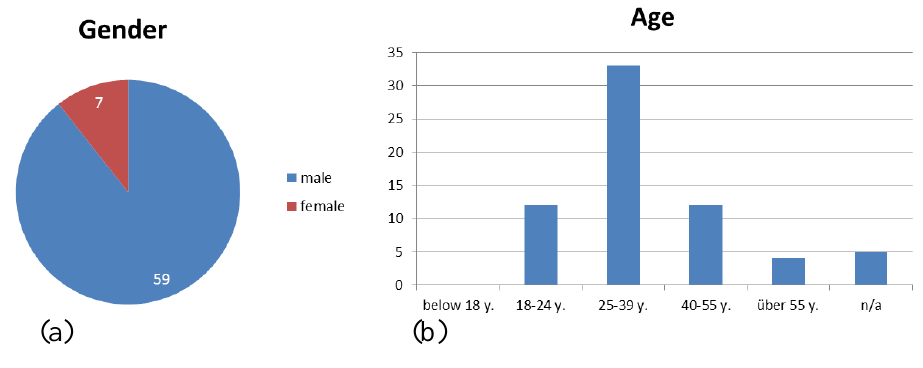
Figure 4. Gender and age of the